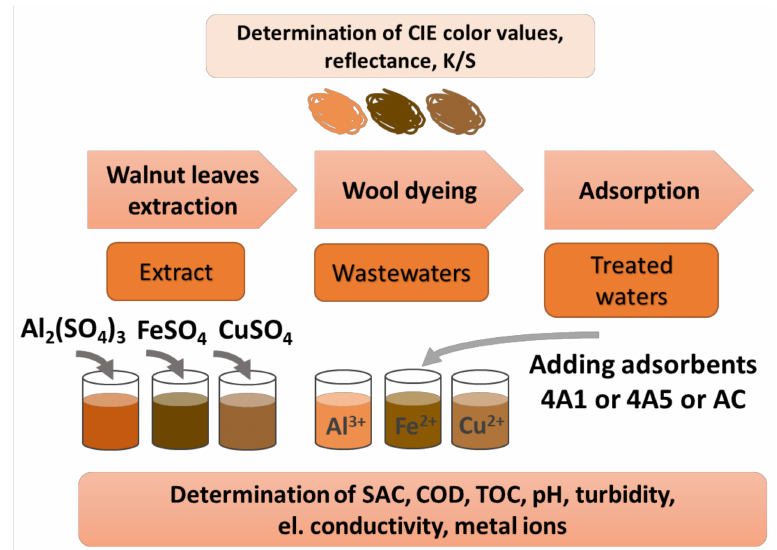
Figure 1. Scheme of the experimental